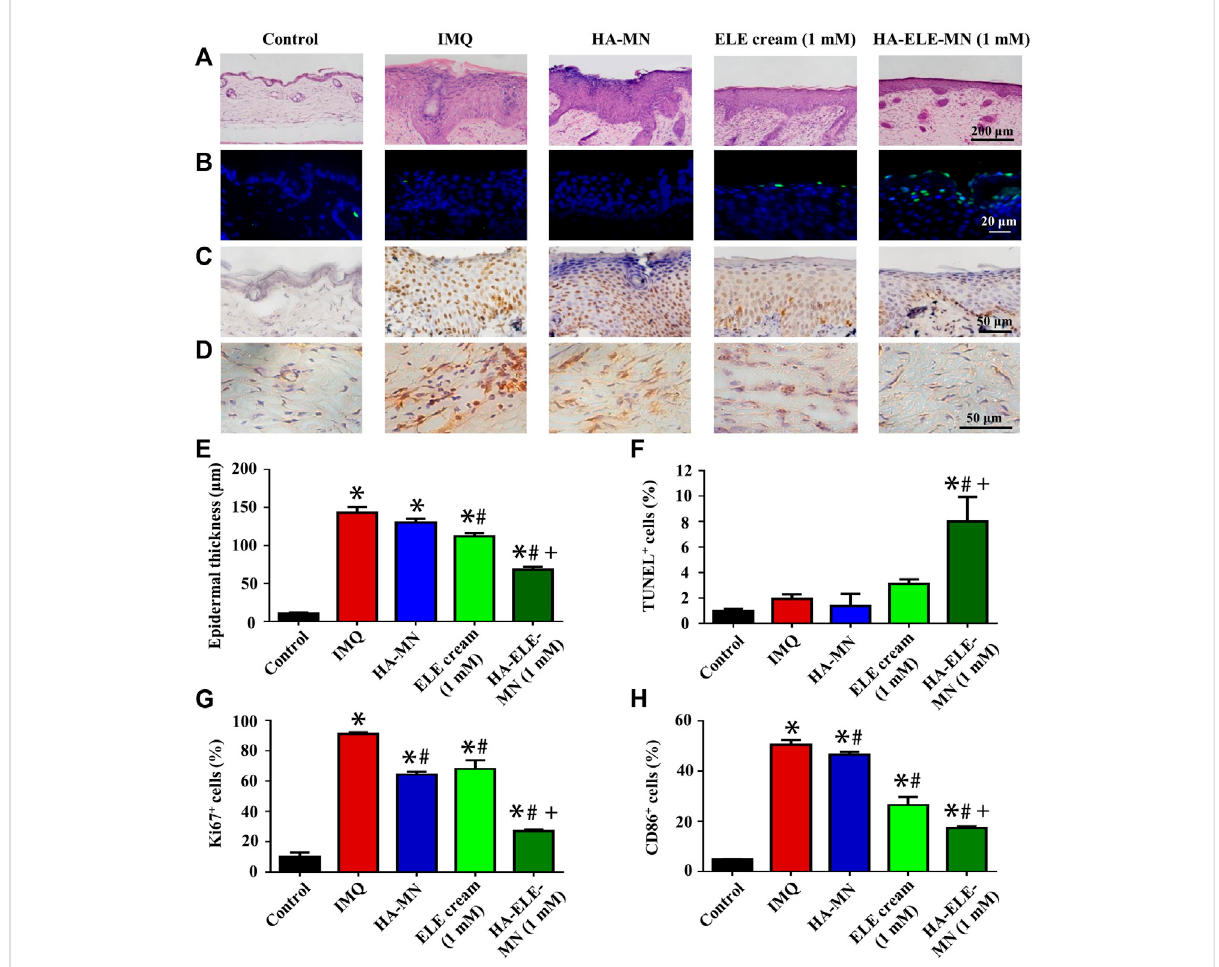
Histopathological analysis of skin samples in IMQ-induced psoriasis model after treated with HA-ELE-MN (1mM). (A) H&E staining for the assessment of epidermal thickness. (B) TUNEL staining. Green indicates apoptotic cells, blue indicates cell nucleus. (C – D) Immunohistochemical staining of ki67 and CD86. (E – H) Quantitative analysis of the epidermal thickness, TUNEL positive (apoptotic) cells, ki67 + , and CD86 + cells. * p < 0.05 versus control, # p < 0.05 versus IMQ, + p < 0.05 versus ELE cream. Error bars indicate SEM (n =